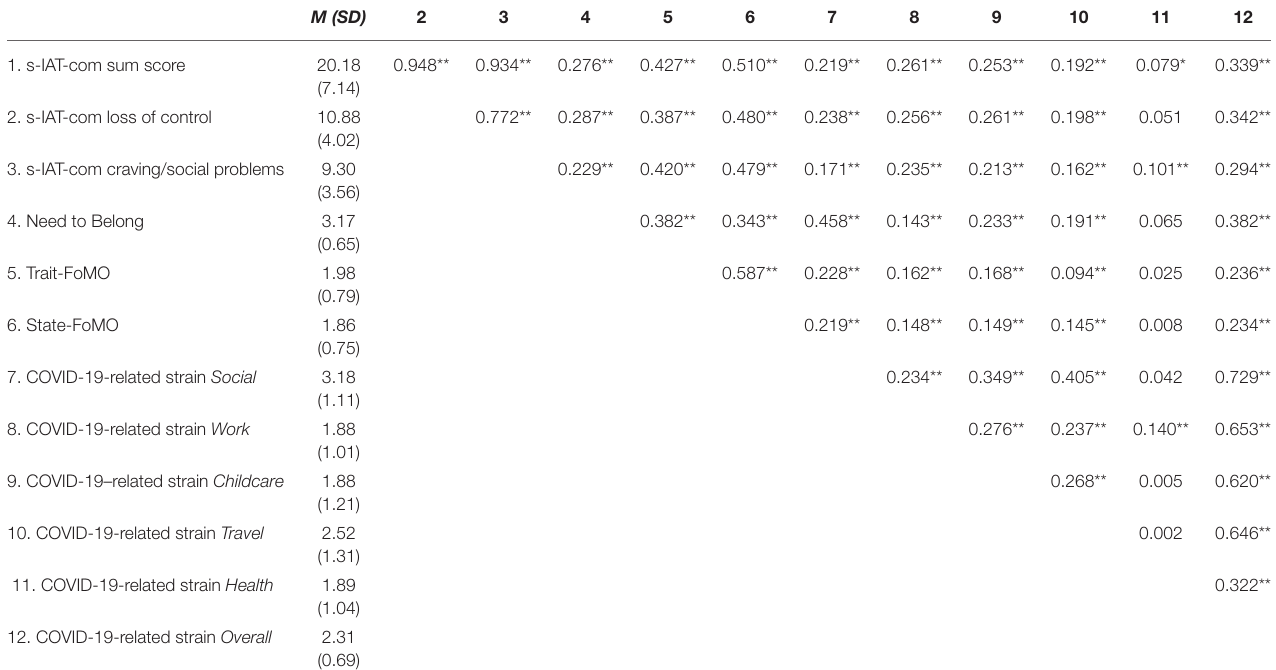
TABLE 3 | Descriptive statistics and bivariate correlations between the symptom severity of a problematic use of social networks and the applied scales.